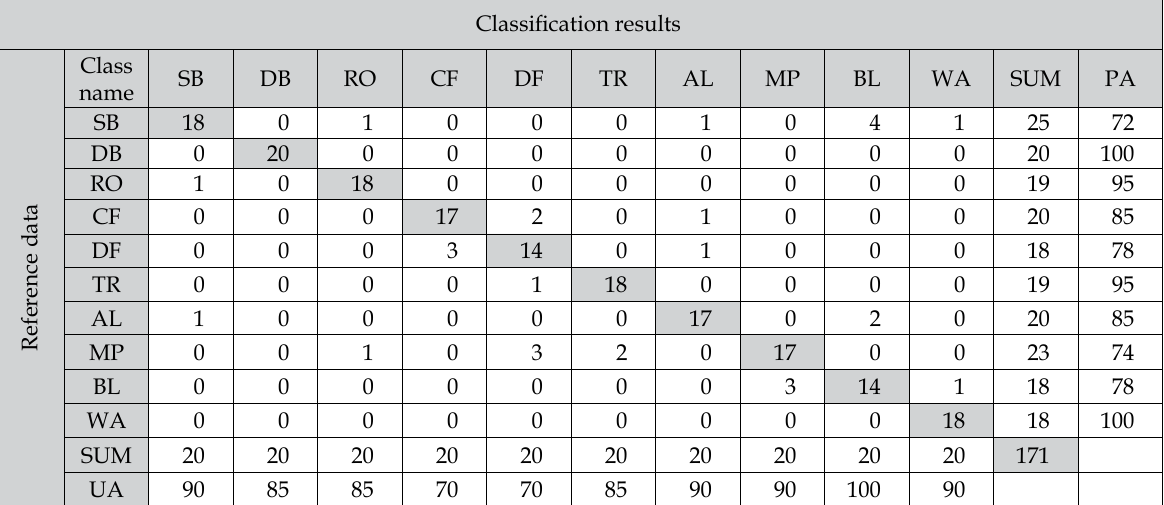
table 4. error matrix for the dobczyce water catchment area (886 ha).